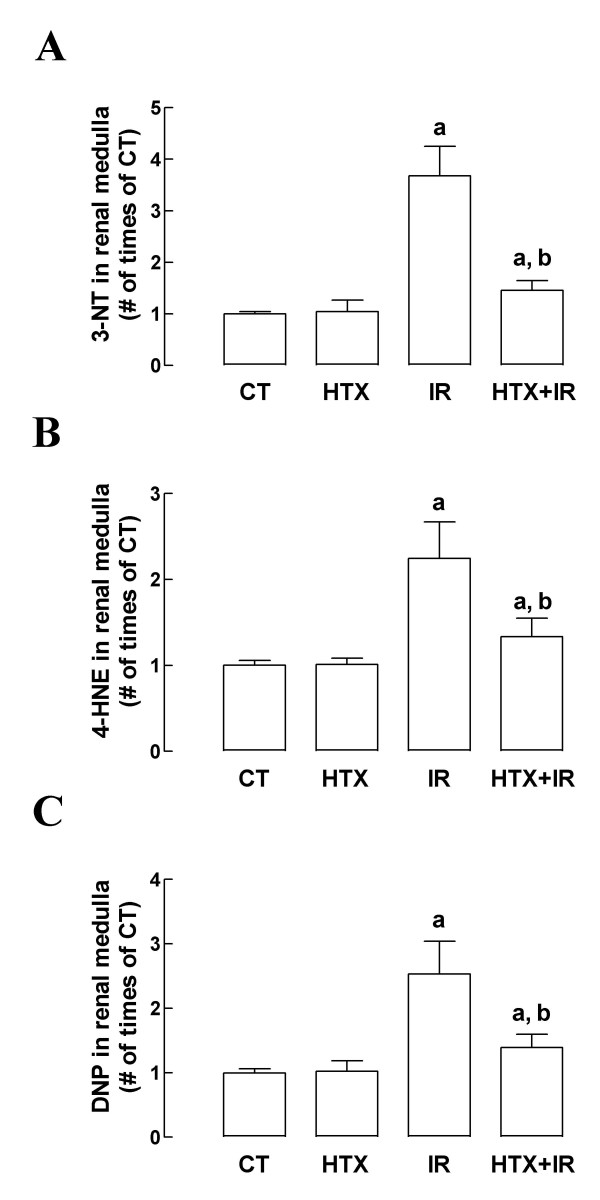
Quantitative immunostaining of 3-NT, 4-HNE, and DNP-modified proteins in renal medulla of the four groups of rats studied: CT, HTX, IR, and HTX+IR. n = 4 rats and 10 determinations/rat. Mean ± SD. aP < 0.001 vs. control, bP < 0.001 vs. IR.